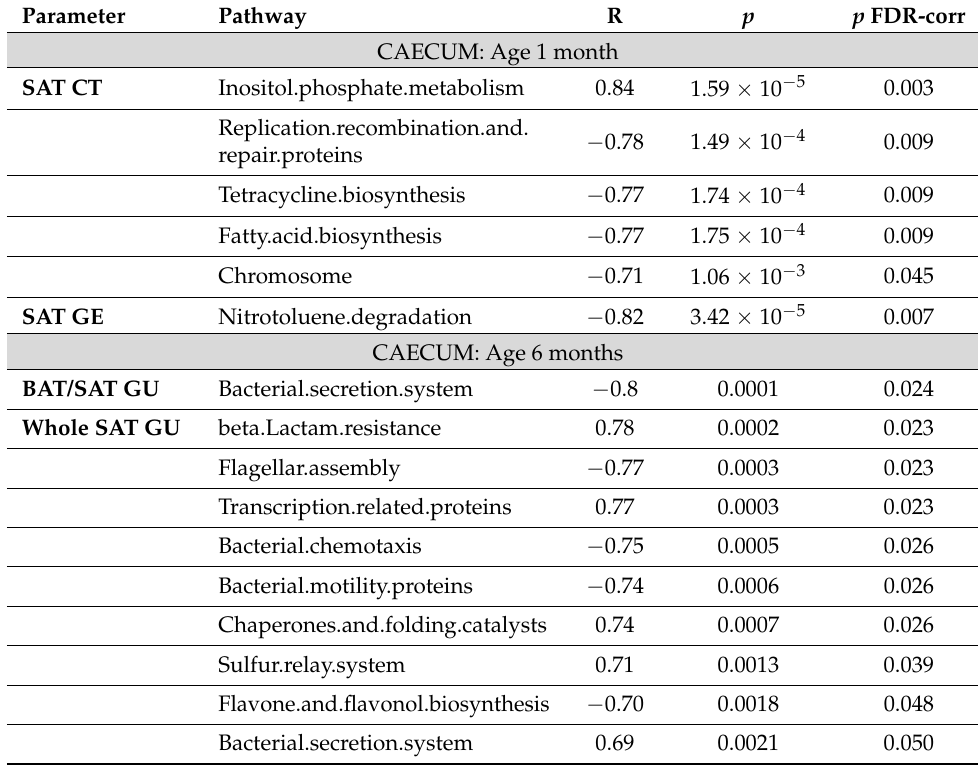
Table 3. Relationships linking imaging data and metabolic